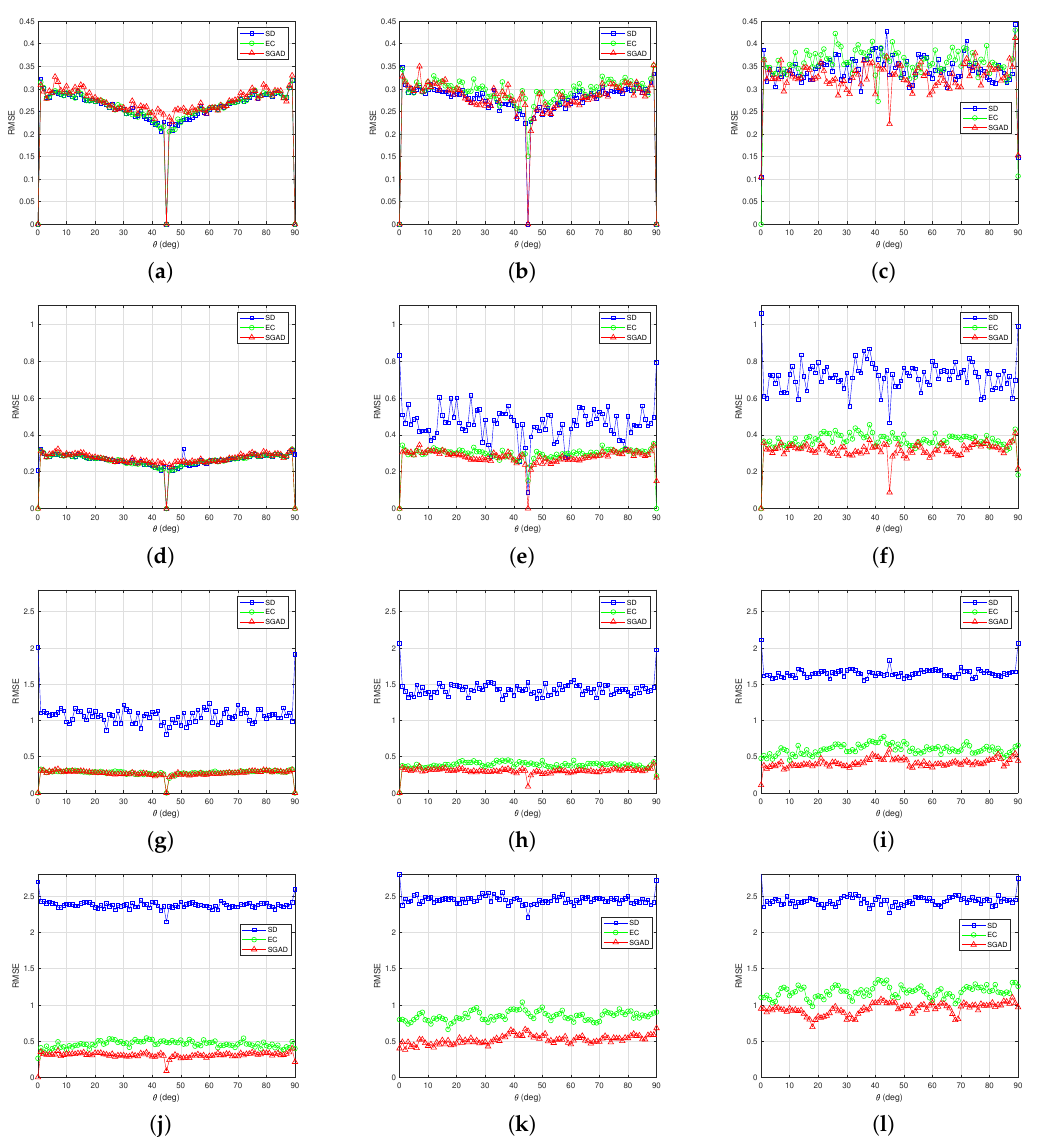
Figure 6. Root mean square errors (RMSEs) of simulation image line detection against line normal angle ( θ ) for various noise strengths ( σ n ) and line widths ( w ) with constant smoothing factor, σ s = 1.0, and line width ( a – c ) w = 2; ( d – f ), w = 4; ( g – i ) w = 6; and ( j – l ) w = 8 pixels. Noise strength ( a , d , g , j ) σ n = 10/255; ( b , e , h , k ) σ n = 30/255; and ( c , f , i , l ) σ n =